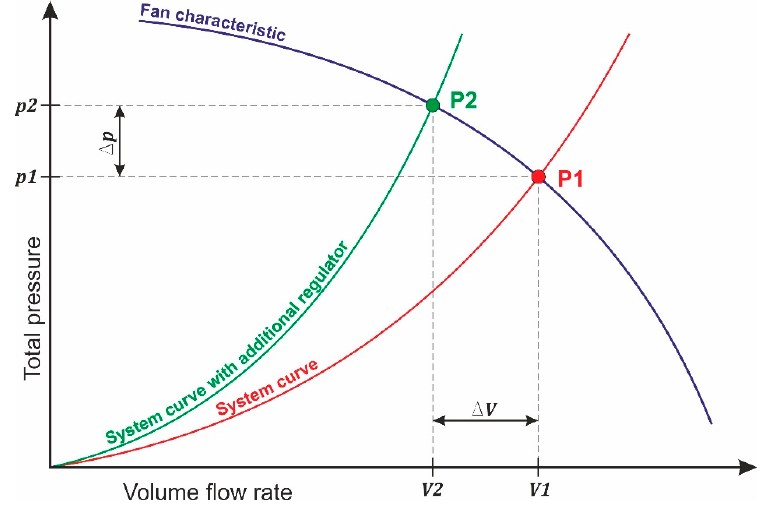
Figure 2. Idea of regulation by throttling.